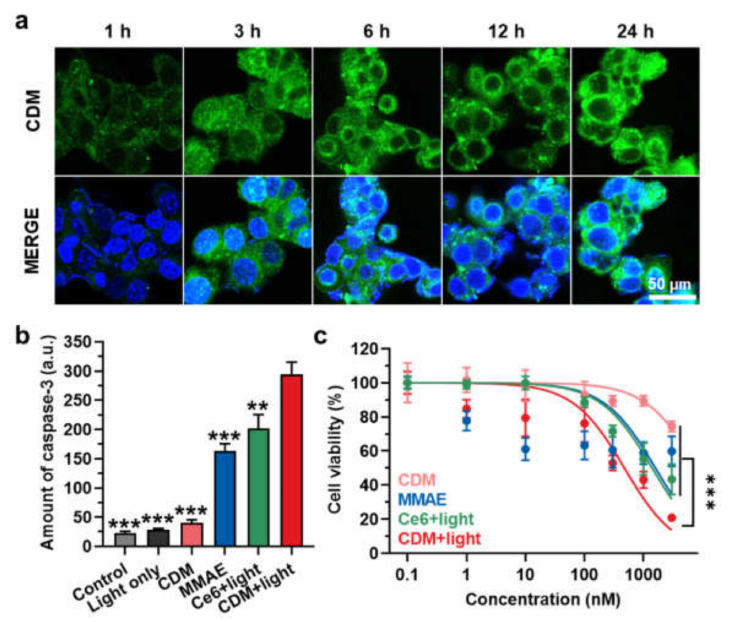
Figure 3. In vitro cytotoxicity and caspase-3 overexpression by CDM. ( a ) Time-dependent cellular uptake of CDM in human pancreatic cancer cell, KPC960. ( b ) The caspase-3 expression levels in KPC960 cells after treatment of CDM, MMAE, or Ce6. CDM- or Ce6-treated KPC960 cells were exposed to visible light with power of 40 mW for 5 min. The asterisks in Figure indicate the comparison to the CDM+light group. ( c ) The viability of KPC960 cells after treatment of CDM, MMAE, or Ce6. CDM- or Ce6-treated KPC960 cells were exposed to visible light with power of 40 mW for 5